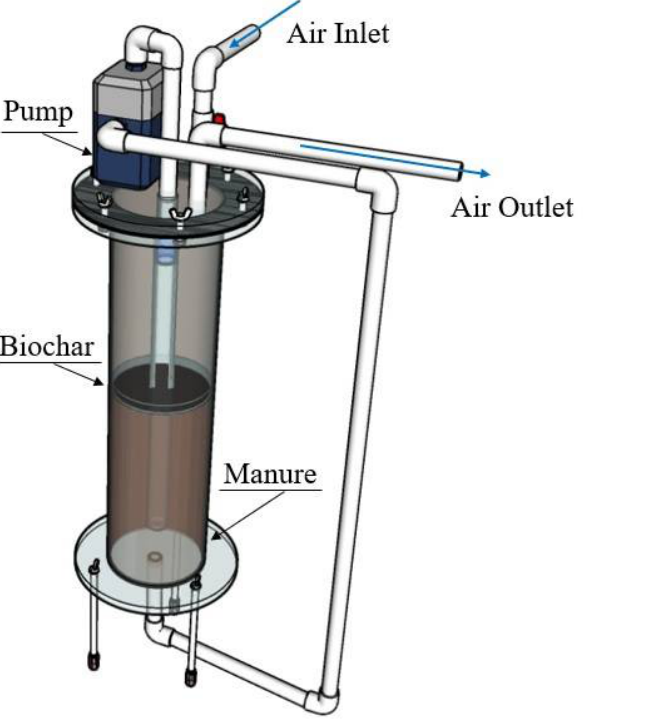
Figure 1. The schematic of the reactor to simulate the process of manure agitation before pump- out.